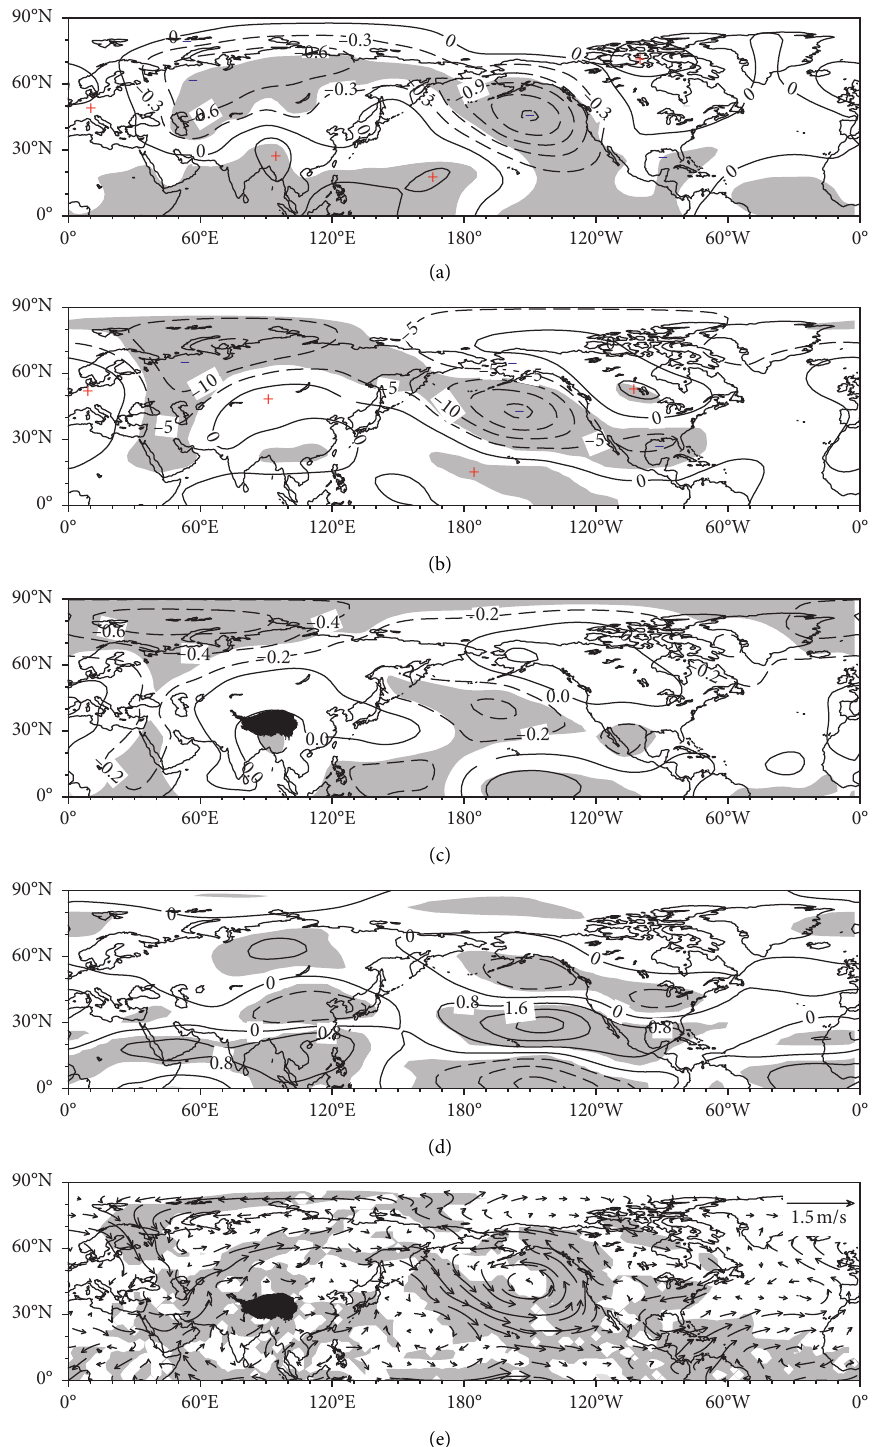
Figure 9: The same as in Figure 7 but for I NP in configuration of upper and lower circulation systems is anomaly (Figure 10(a)), and a ridge lies between Lake conducive to the arrival of cold air to in North China from Balkhash and Lake Baikal (Figure 10(b)). The East Asian the Greenland Sea, East European Plain, West Siberia, and temperate is stronger and subtropical jet is weaker west of Lake Baikal (Figure 10(e)), resulting in frequent (Figure 10(d)). There is a cold air stack between Victoria ECEs. Island and the Greenland Sea (Figure 10(c)). The